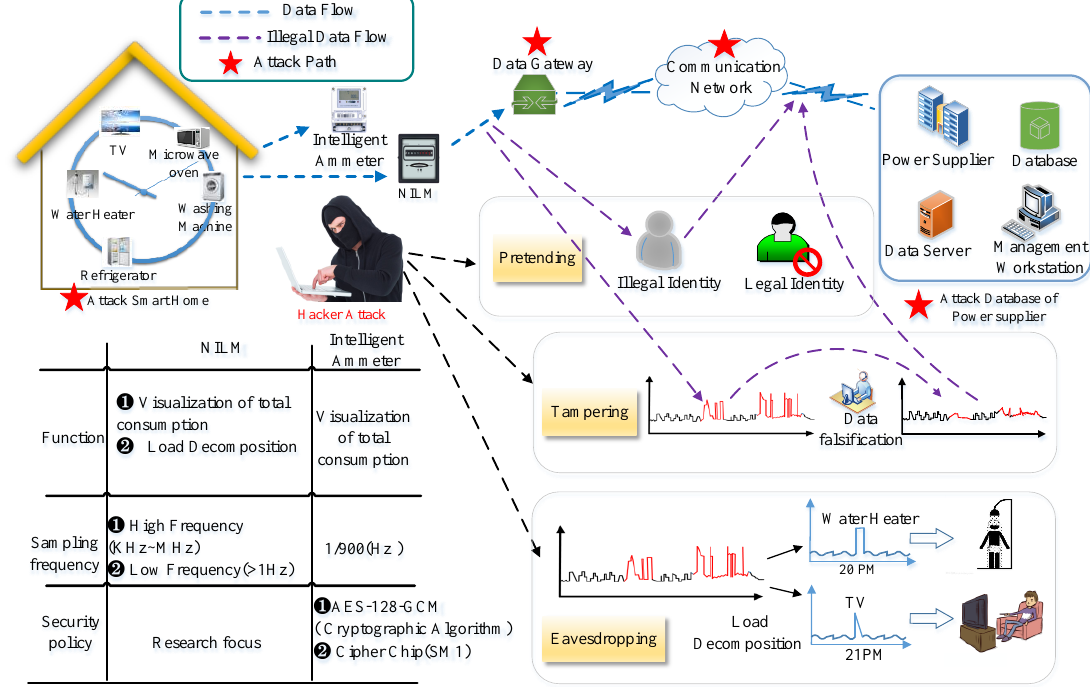
Figure 3. The manner of NILM attack compared with intelligent ammeter.